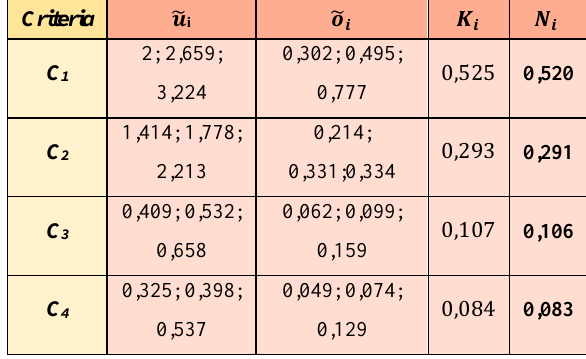
Table 2. Standardized criteria